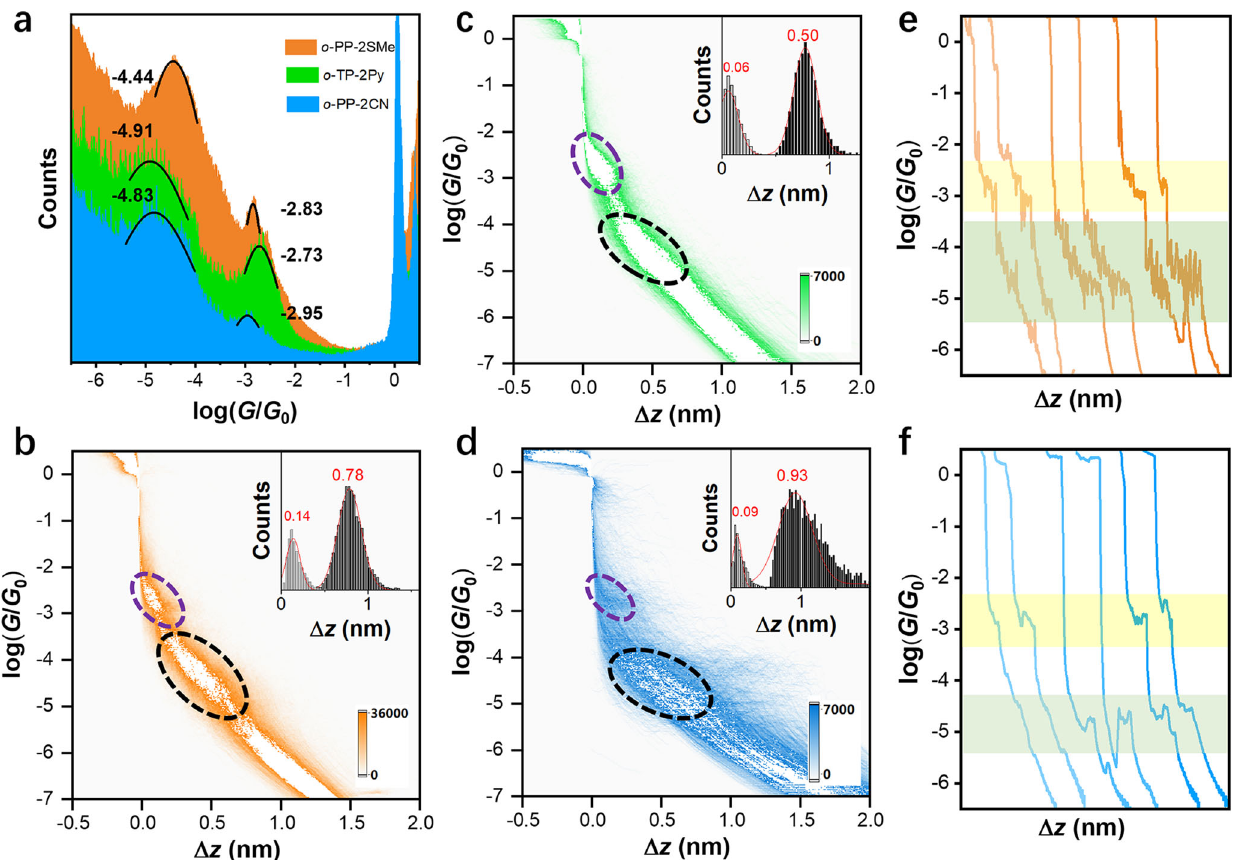
Fig. 3 STM-BJ measurements of o -PP derivatives in the concentration of 0.2 mM. a One-dimensional conductance histograms for o -PP-2SMe, o -TP-2Py, and o -PP-2CN respectively, along with the values of the conductance peaks labeled beside the fi tting curves. b – d Two-dimensional conductance – displacement histograms for o -PP-2SMe, o- TP-2Py, and o -PP-2CN, respectively. The purple dashed circles label the density clouds of HC state, while the black dashed circles label the density clouds of LC states. Insets: the light-gray histograms refer to relative displacement distributions of HC states, while the dark-gray histograms refer to relative displacement distributions of LC states. e , f Typical individual traces for o -PP-2SMe and o -PP-2CN, respectively. The yellow frames correspond to the plateau of HC states, while the green frames correspond to the plateau of LC states.